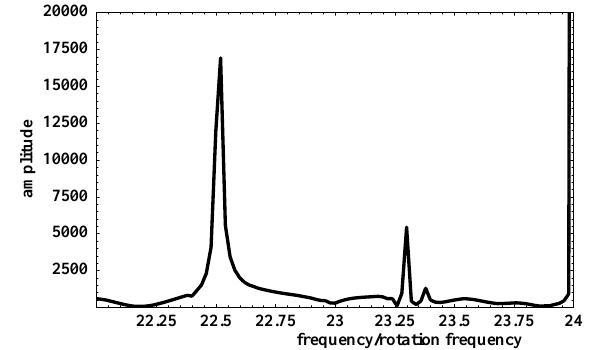
FIG. 15. Spectrum of (cid:5) y 4 (cid:6) at 375 turns for (cid:1) n x , n y (cid:2) (cid:1) (cid:1) 5.74, 5.71 (cid:2) .